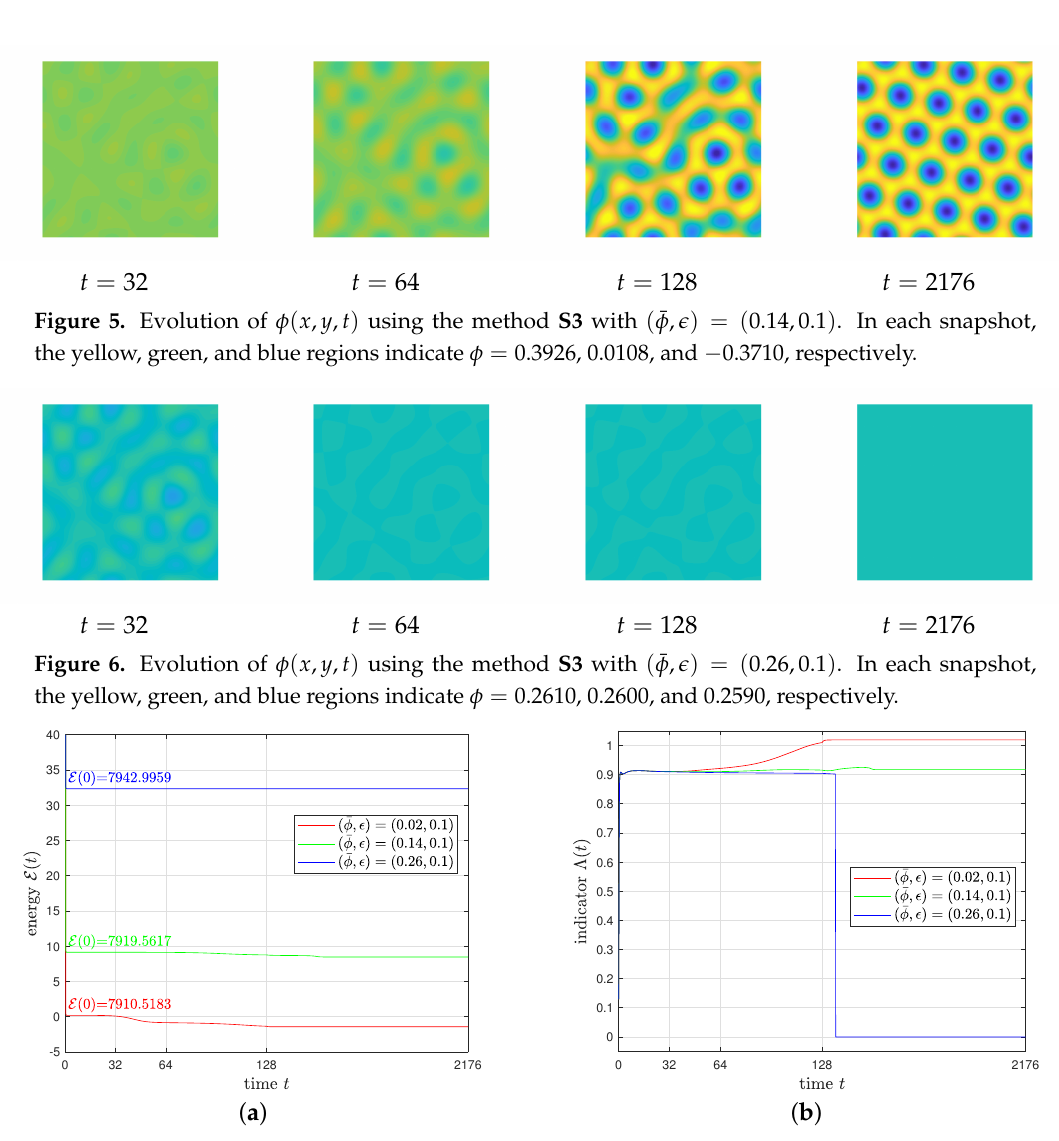
( t ) and ( b ) Λ ( t ) with ( ¯ φ , (cid:101) ) used in Figures E